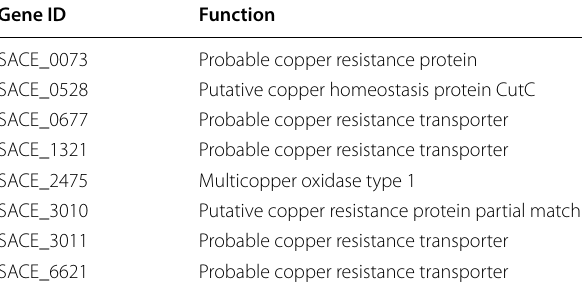
Table 3 Genes related to copper metabolism and their functions in S. erythraea genome